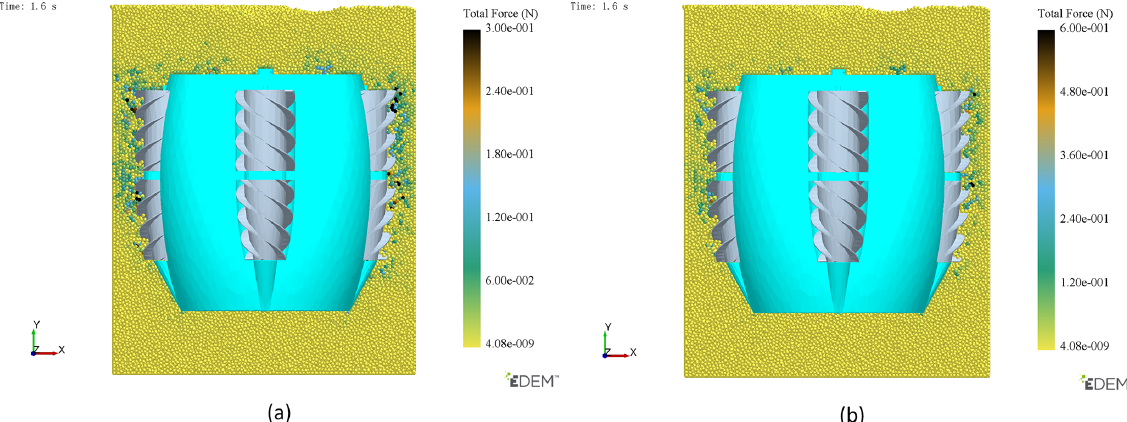
Figure 12. t = 1 . 6s force on particles around the screw. The maximum value of the legend in panel (a) is 0.3N, the maximum value of legend in panel (b) is 0.6N, and the minimum values of the two are the same.